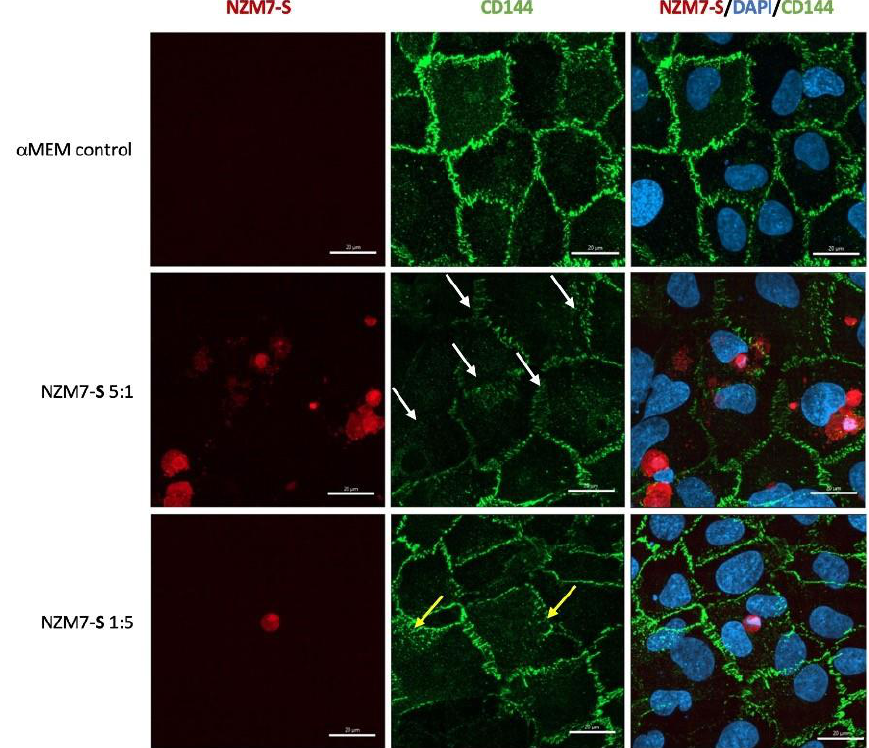
Figure 10. Representative images displaying changes in CD144 expression in human cerebral mi- crovascular endothelial cells after NZM7-S addition detected by confocal microscopy. hCMVECs were seeded at 20,000 cells per well, and NZM7-S were live stained with CytoTrack Red (CTR) and applied to the apical face of a confluent endothelial monolayer. Cells were co-cultured for 4 h, washed and then fixed. Two E:T ratios of 5:1 and 1:5 are shown, labelled on the left. Media control was αMEM. Junctions were visualised with anti -CD144 (green), and nuclei were visualised using Hoechst. White arrows highlight stretched junctional borders. Yellow arrows highlight punctate CD144 staining within the endothelial cell body. Images were acquired with the Zeiss LSM 800 Airyscan confocal microscope. Scale bars = 20 µm.